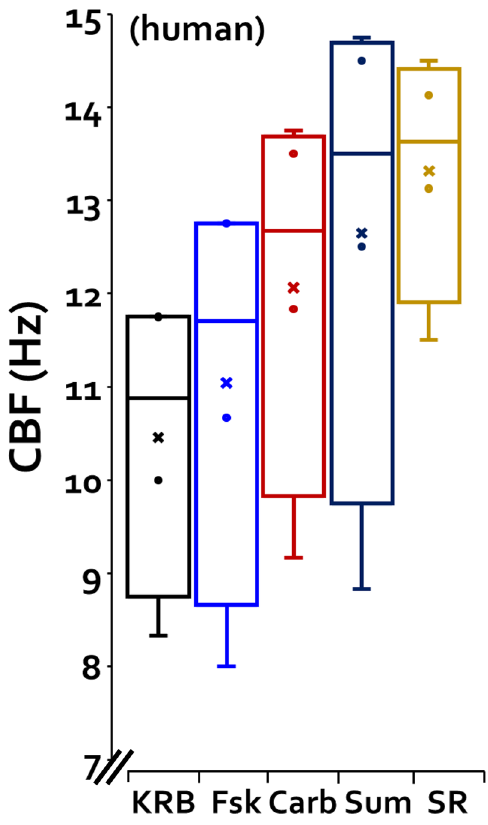
Figure 5. Agonists stimulated ciliary beat frequency with additive effects. Ciliary beat frequency was measured in human nasal mucosa from 4 patients. CBF (in Hz) of unstimulated tissues at 37 °C in Krebs buffer (KRB) was 10.46 ± 0.95. Agonists alone increased CBF by small amounts that did not reach significance in this small sample: carbachol: 11.04 ± 1.3 (5.3%) and forskolin 12.06 ± 1.22 (9.8%). The combined agonists increased CBF significantly 13.31 ± 0.77 (27.2%, n = 4, P < 0.05) when comparing difference in CBF (∆) to unstimulated CBF (KRB), but not to the arithmetical sum of ∆CBF to the combined agonists: 2.85 ± 0.76 (synergy paradigm) versus 2.19 ± 0.66 (arithmetic sum) (n = 4, P =